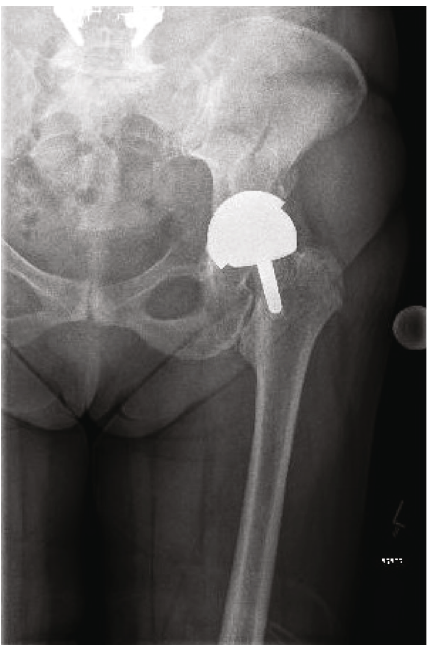
Figure 1: Initial X-ray of the fracture. After a stumble fall, the patient presented herself to an orthopedist. An anteroposterior X- ray of the pelvis was conducted and showed a fracture of the pelvis with a dislocation of the